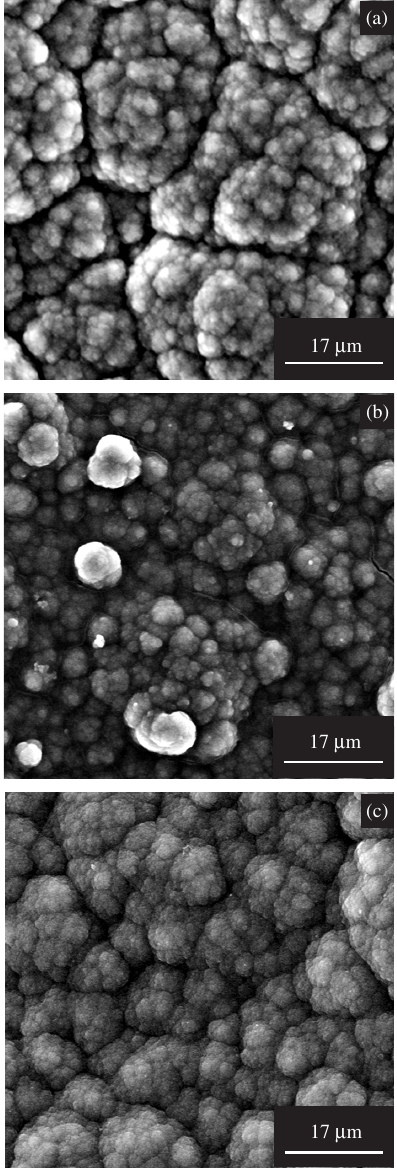
Figure 5. SEM micrographs of aluminum surfaces coated with PPy films deposited galvanostatically at 2.5 mA.cm -2 from aqueous media containing 0.5 mol.L -1 pyrrole + 0.2 mol.L -1 of each electrolyte: a) tartaric acid; b) oxalic acid; and c) citric acid.